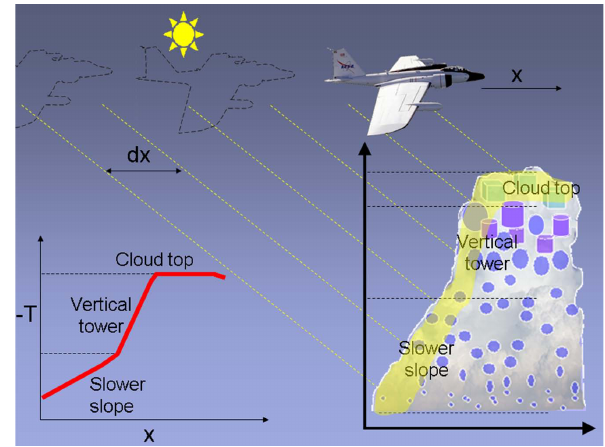
formed from high altitude aircraft or satellite. In this geometry, the cloud is always observed from a single view angle perspective and different altitudes of the cloud are observed by moving the aircraft rather than employing a moving scan mirror. The geometry can al- ways be optimized to reduce shadows and other issues. The insert in the lower left corner shows an idealized measure of temperature as a function of height of the cloud to the right. The more vertical the cloud wall, the more quickly the temperature changes with height. Cloud tops display almost constant temperature with the satellite displacement. The expression “slower slope” in the figure refers to regions where the cloud wall is not vertical, producing slower changes in temperature as a function of cloud